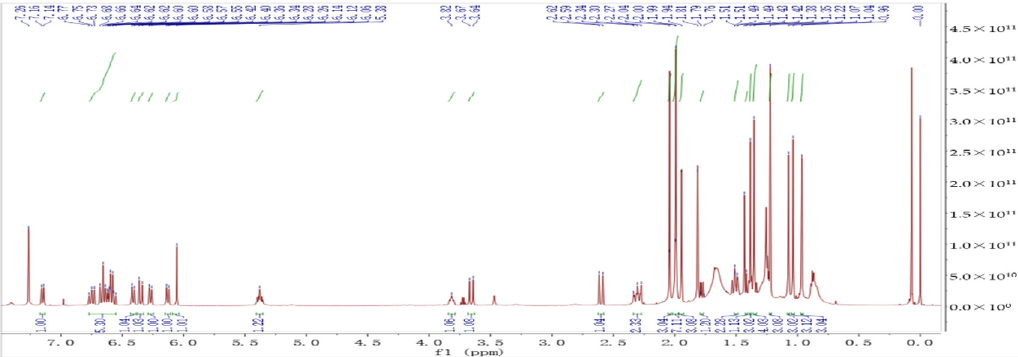
Figure 10. 1 H-NMR (600 MHz, CDCl 3 ) spectrum of FX obtained from the solution A4.